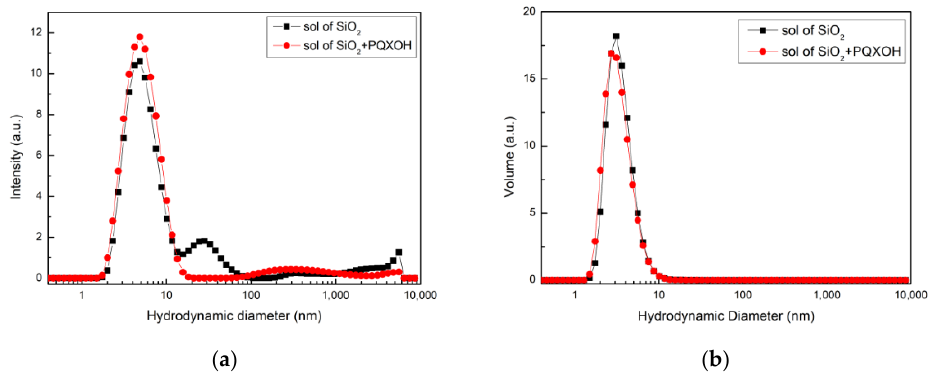
Figure 4 . Hydrodynamic diameters of particles in SiO 2 sol (sol A) and SiO 2 + PQXOH sol (sol B); size distribution by intensity ( a ), and size distribution by volume ( b ).